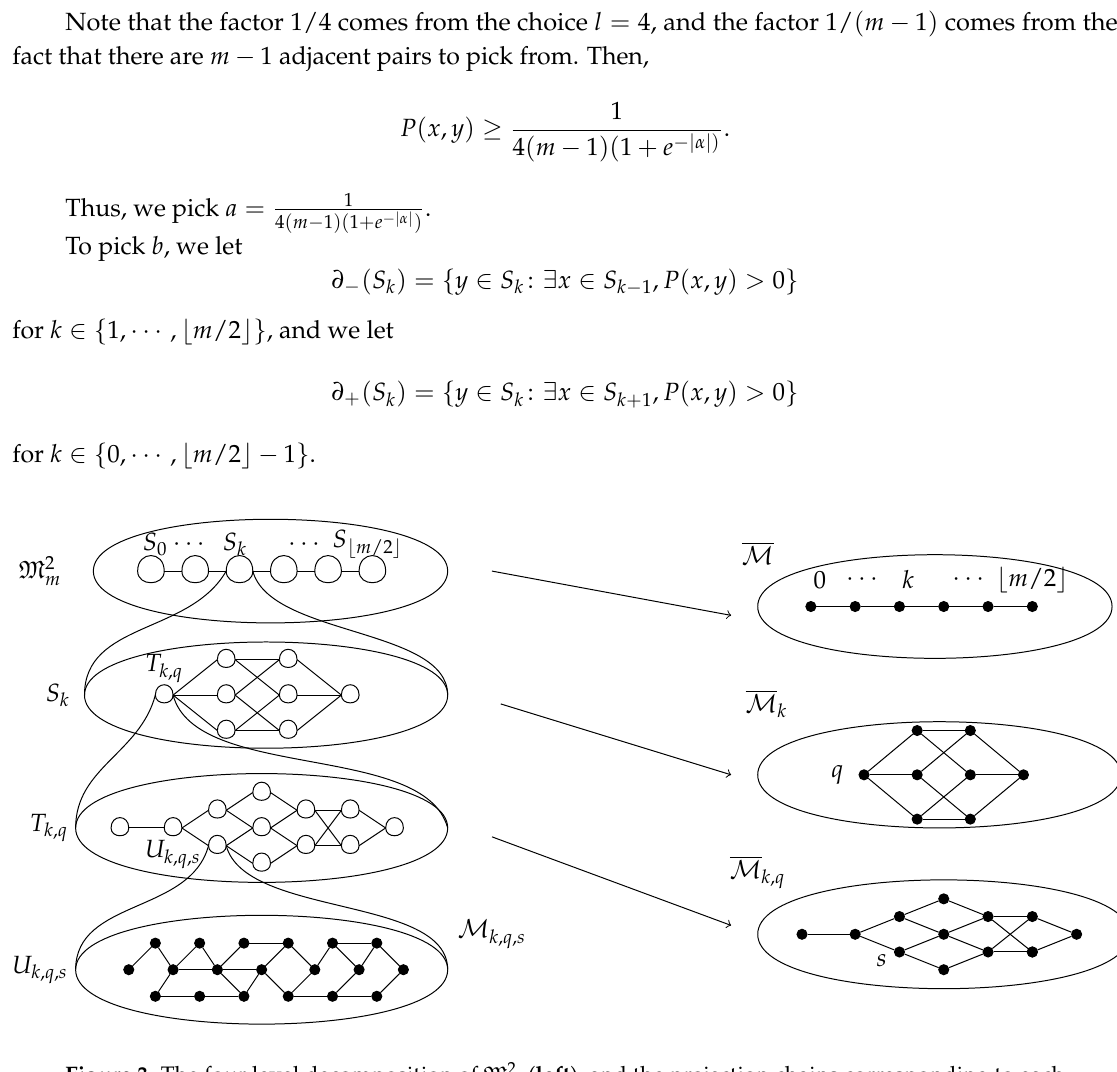
Figure 3. The four level decomposition of M 2 m ( left ), and the projection chains corresponding to each decomposition ( right